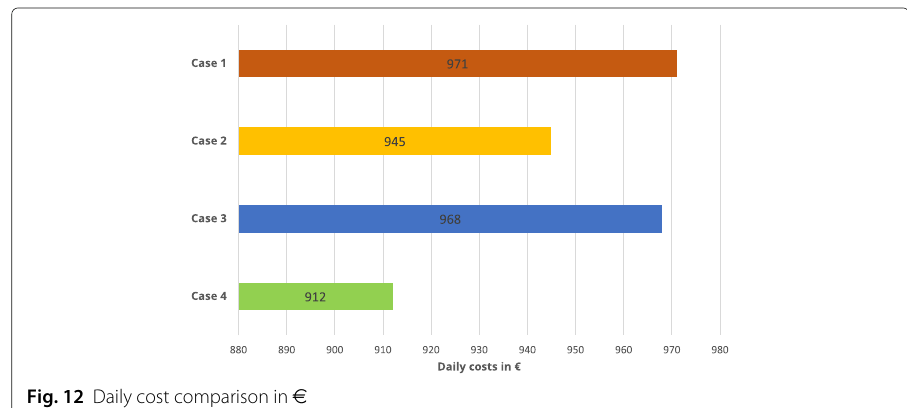
Fig. 12 Daily cost comparison in